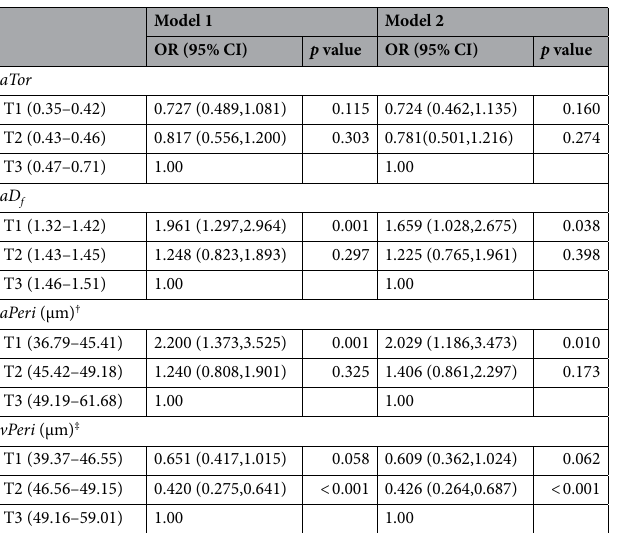
Table 3. Adjusted odds ratio of microalbuminuria in relation to selected retinal vascular measurements in tertile. *Model 1 adjusted for age and sex; **Model 2 adjusted for age, sex, duration, smoking, BMI, HbA1c, SBP, DBP, total cholesterol, triglyceride, high-density and low-density lipoprotein; † Arteriolar caliber measurements were further adjusted for vCtr , vMdl , and vPeri . ‡ Venular caliber measurements were further adjusted for aCtr , aMdl , and aPeri